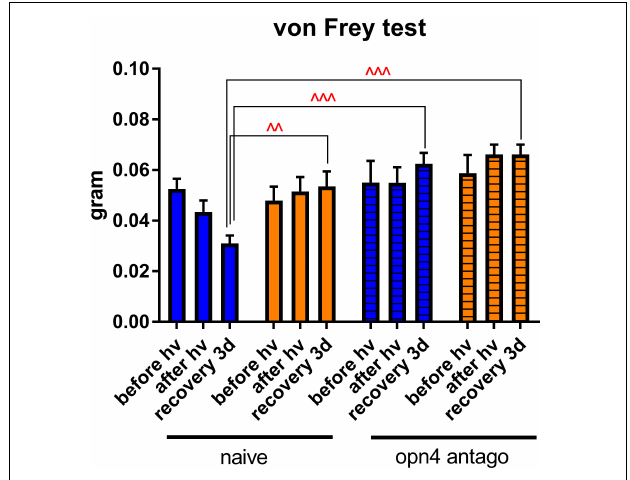
FIGURE 12 | Role of melanopsin in corneal sensitivity. Measurement of corneal mechanical sensitivity performed by means of von Frey test. Greater values mean lower corneal sensitivity. Test was performed in naïve mice (clear bars, the same results as the ones presented in the Figure 2 ) and in mice intraperitoneally ( ip , 30 mg/kg) injected with melanopsin antagonist ( opn4 antago ) 15 min before the start of the test. For more detail, see “Materials and Methods” section. Statistical significance for the recovery 3d grou p : blue naïve vs. yellow naïve – q = 0.0010, p = 0.0010, blue naïve vs. blue antago opn4 – q = 0.0008, p = 0.0005, blue naïve vs. yellow antago opn4 – q = 0.0004, p = 0.0001. Measurements were made at three time points: before h ν , before the beginning of illumination; after h ν , directly after 3 h of illumination; recovery 3d , after 3 days of recovery in standard illumination conditions of animal unit. Blue and yellow bars correspond to blue and yellow exposures, respectively. All the data are presented as mean ± SEM. Differences were considered significant when p < 0.05 ( ∧ ), p < 0.01 ( ∧∧ ), p < 0.001 ( ∧∧∧ ) or p < 0.0001 ( ∧∧∧∧